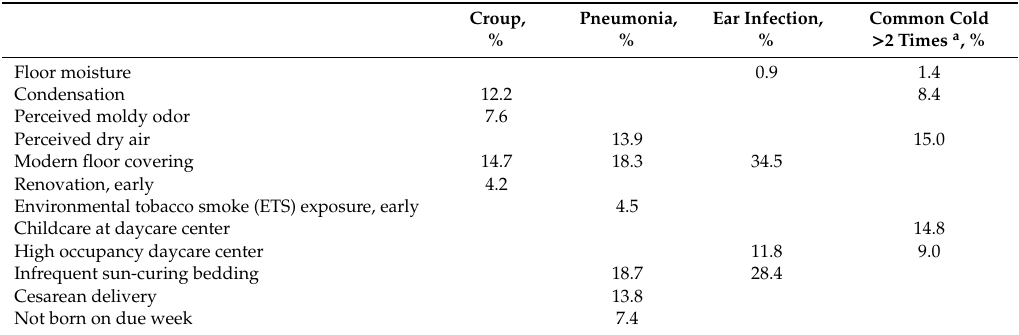
Table 6. Population attributable fractions of home environmental, lifestyle, and biological factors for respiratory infections among children in Tianjin, China. Croup,